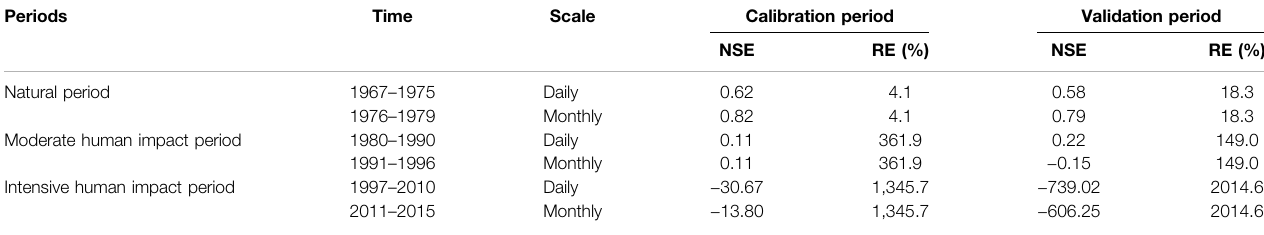
TABLE 3 | Performance measurements of the GR4J model for daily and monthly discharge simulations in the Zhulong River catchment.